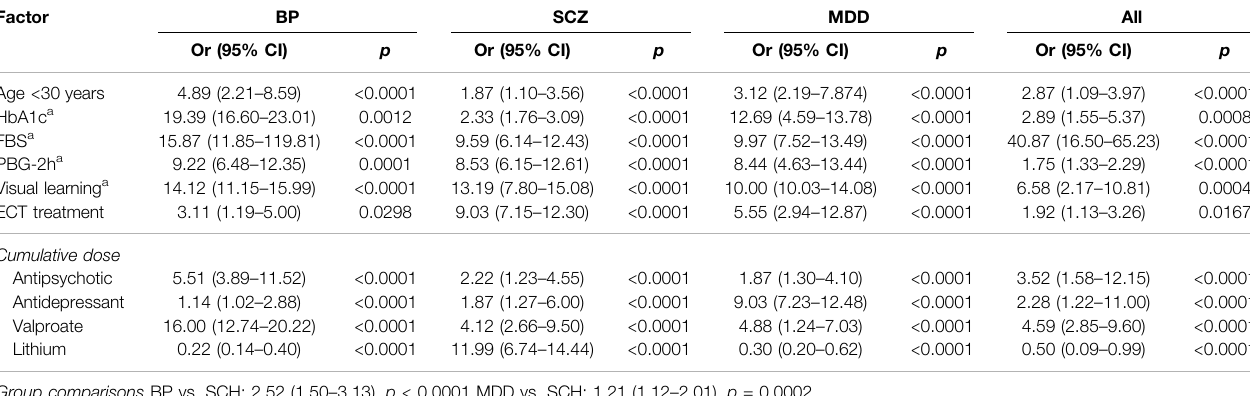
TABLE 5 | Multivariate analysis of HMB risk factors in each diagnosis group and in the total sample.